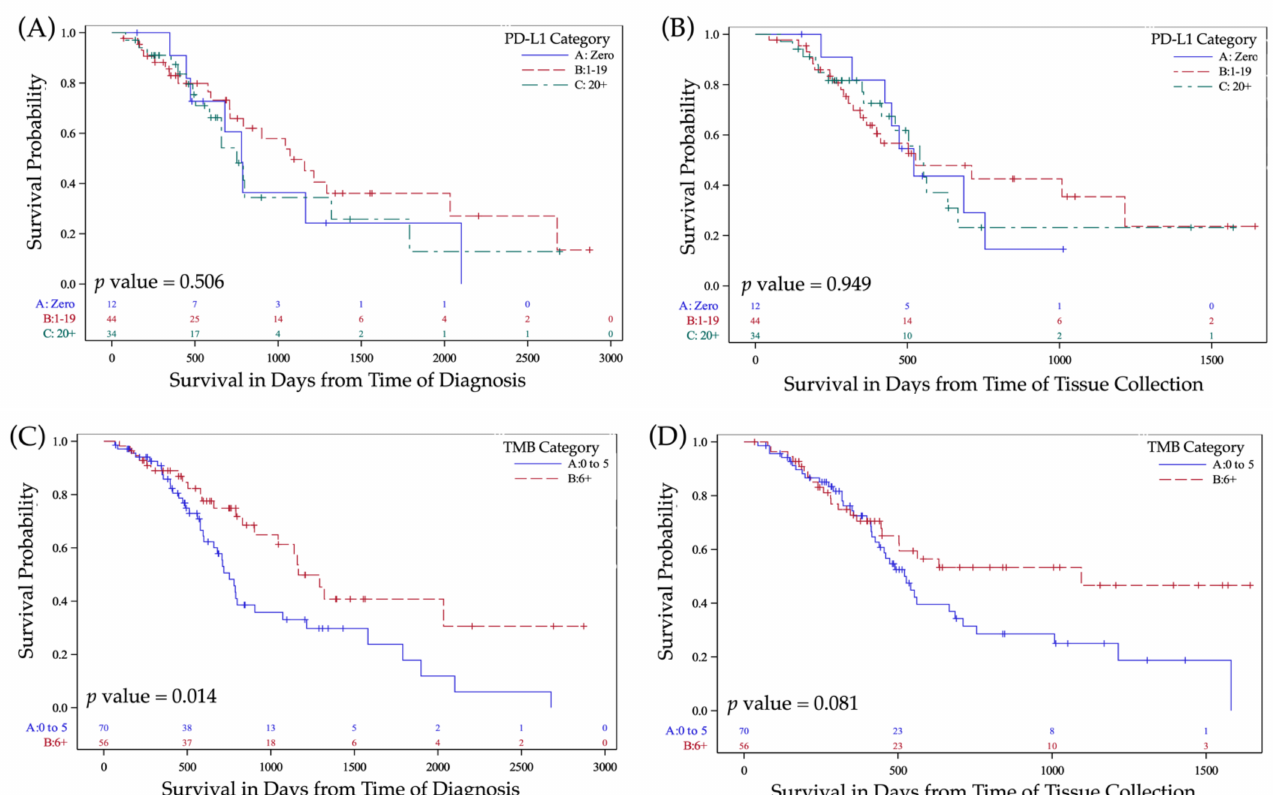
Figure 3. Kaplan –Meier curves for PD-L1 and TMB variables. ( A ) Survival from time of diagnosis in patients with 3tPD-L1-(20+) vs. 3tPD-L1-(1–19) vs. 3tPD-L1-(0); ( B ) Survival from time of tissue acquisition in patients with 3tPD-L1-(20+) vs. 3tPD-L1-(1–19) vs. 3tPD-L1-(0); ( C ) Survival from time of diagnosis in patients with TMB-(6+) vs. TMB-(<6); ( D ) Survival from time of tissue acquisition in patients with TMB-(6+) vs. TMB-(<6). Abbreviations: PD-L1, programmed death